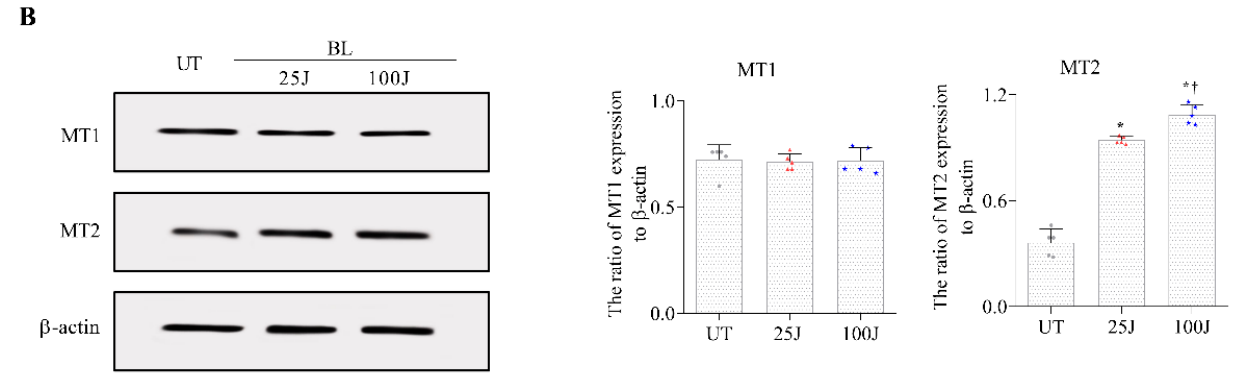
Figure 2. Expression of MT1 and MT2 by IHC ( A ) and Western blotting ( B ) in the cornea of the UT, 25 J BL, and 100 J BL groups, after 14 days of BL exposure. * p < 0.05 vs. UT, † p < 0.05 vs. D3, UT, untreated; BL, blue light.